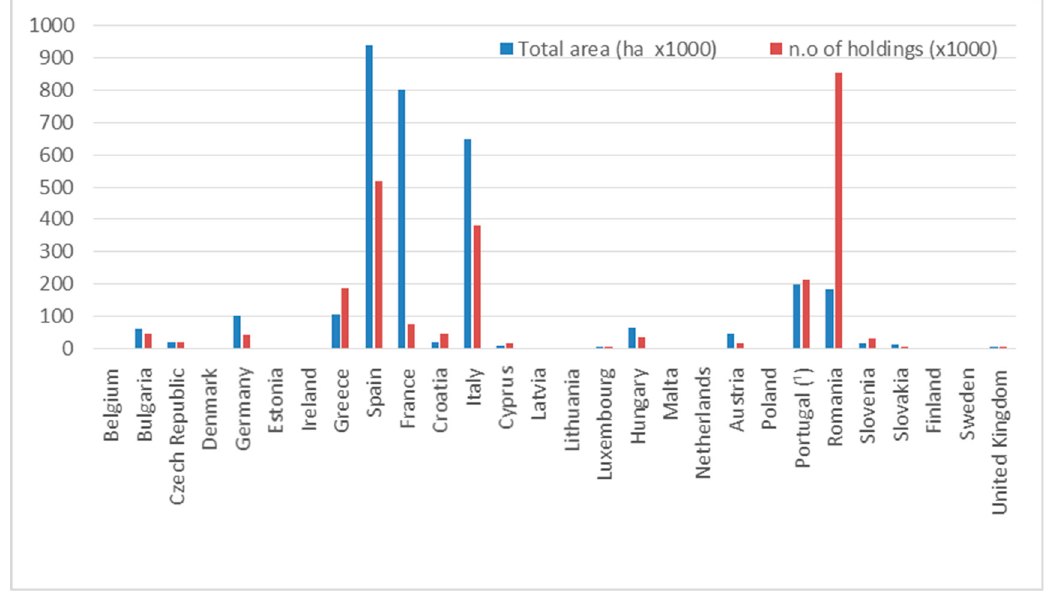
Figure 1. Vineyard holdings in the EU (all values are expressed in thousands), source [46].